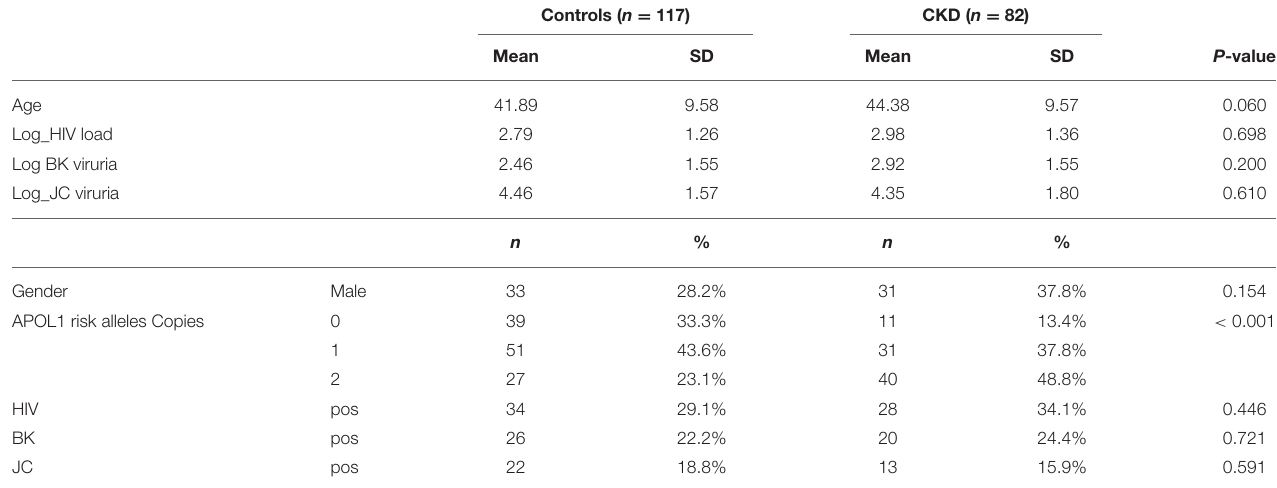
TABLE 1 | Comparison of CKD patients and